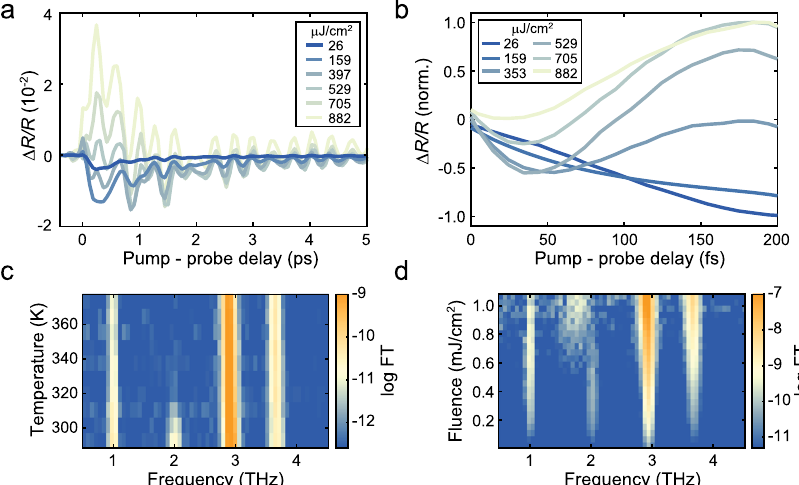
Fig. 2 Photoinduced suppression of the excitonic order. a Δ R / R kinetic at 1200 nm for different values of Φ pump . b Normalised signal collected with smaller time steps to better resolve the behaviour at early times. Data are cut after the coherent artefact for clarity (see Supplementary Note 4). c , d Natural logarithm of the Fourier transform (FT) of the oscillatory component of Δ R / R as a function of temperature ( c ) and Φ pump ( d